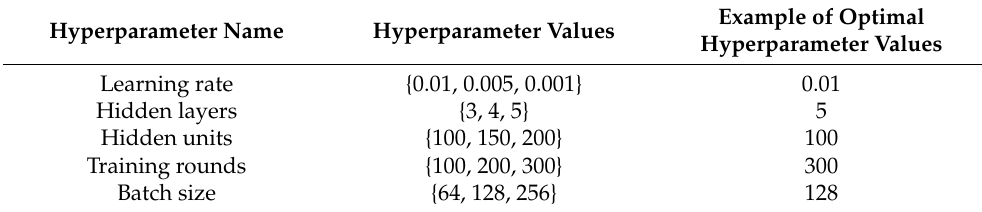
Table 4. Candidate and optimal sets of hyperparameters for the LSTM